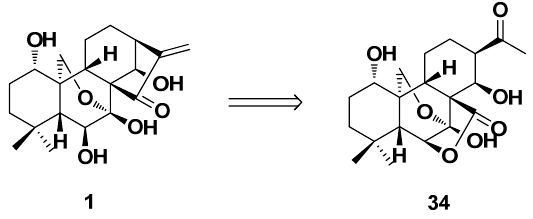
Figure 17. The synthesis of 15,16- seco - ent -kaurane rubescensin S ( 34 ) from oridonin.